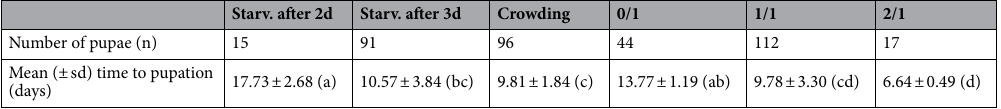
Table 2. Number of pupae formed (sample size for size measurement, fat content quantification, and time to pupation), and mean time to pupation (± sd) when development occurred on different diets. Different letters indicate significant differences based on estimated marginal means comparisons (p value < 0.05).